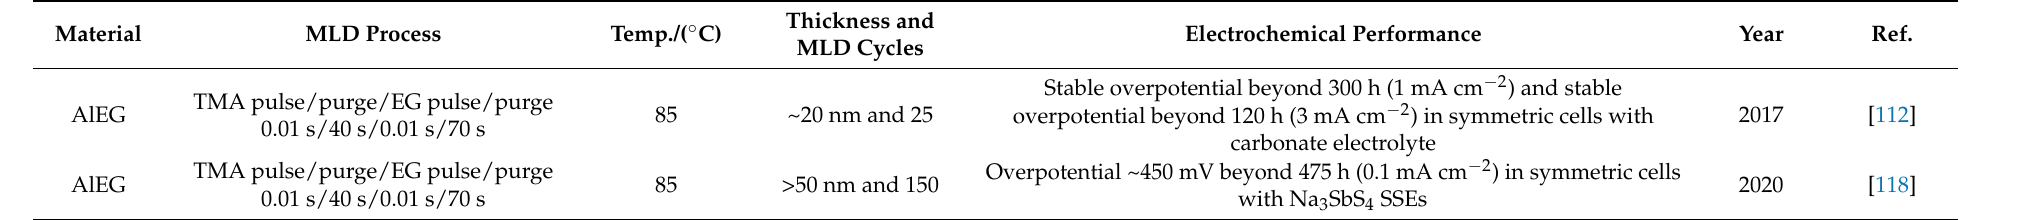
Table 4. Summary of MLD Surface Coating Na